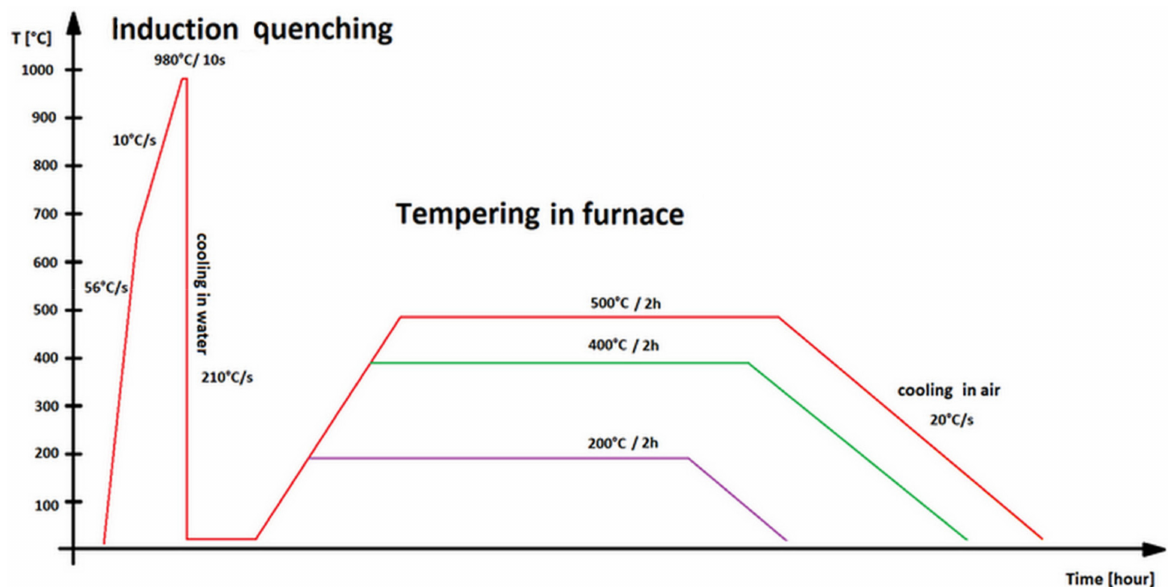
Figure 1. Time–temperature profile of the quenching and tempering